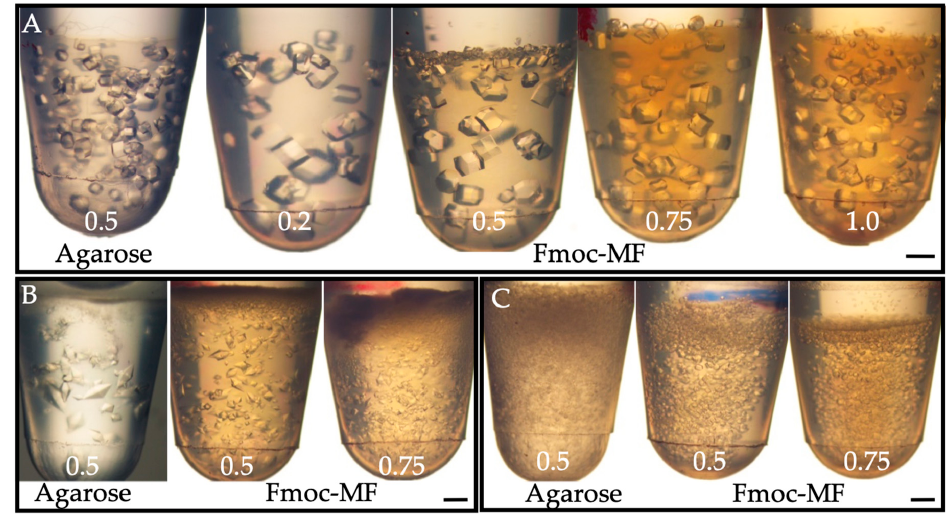
Figure 1. Lysozyme ( A ), thaumatin ( B ), and glucose isomerase ( C ) crystals obtained in agarose and Fmoc ‐ Met ‐ Phe ‐ OH (Fmoc ‐ MF) gel at different concentrations (% w / v , depicted in white number) by the 2 ‐ L counter ‐ diffusion set ‐ up. Scale bars correspond to 1.0 mm. Table 2. Summarized the data collection conditions and final statistical values of lysozyme crystals in Fmoc ‐ MF and in agarose hydrogels (data in brackets correspond to high ‐ resolution shell).